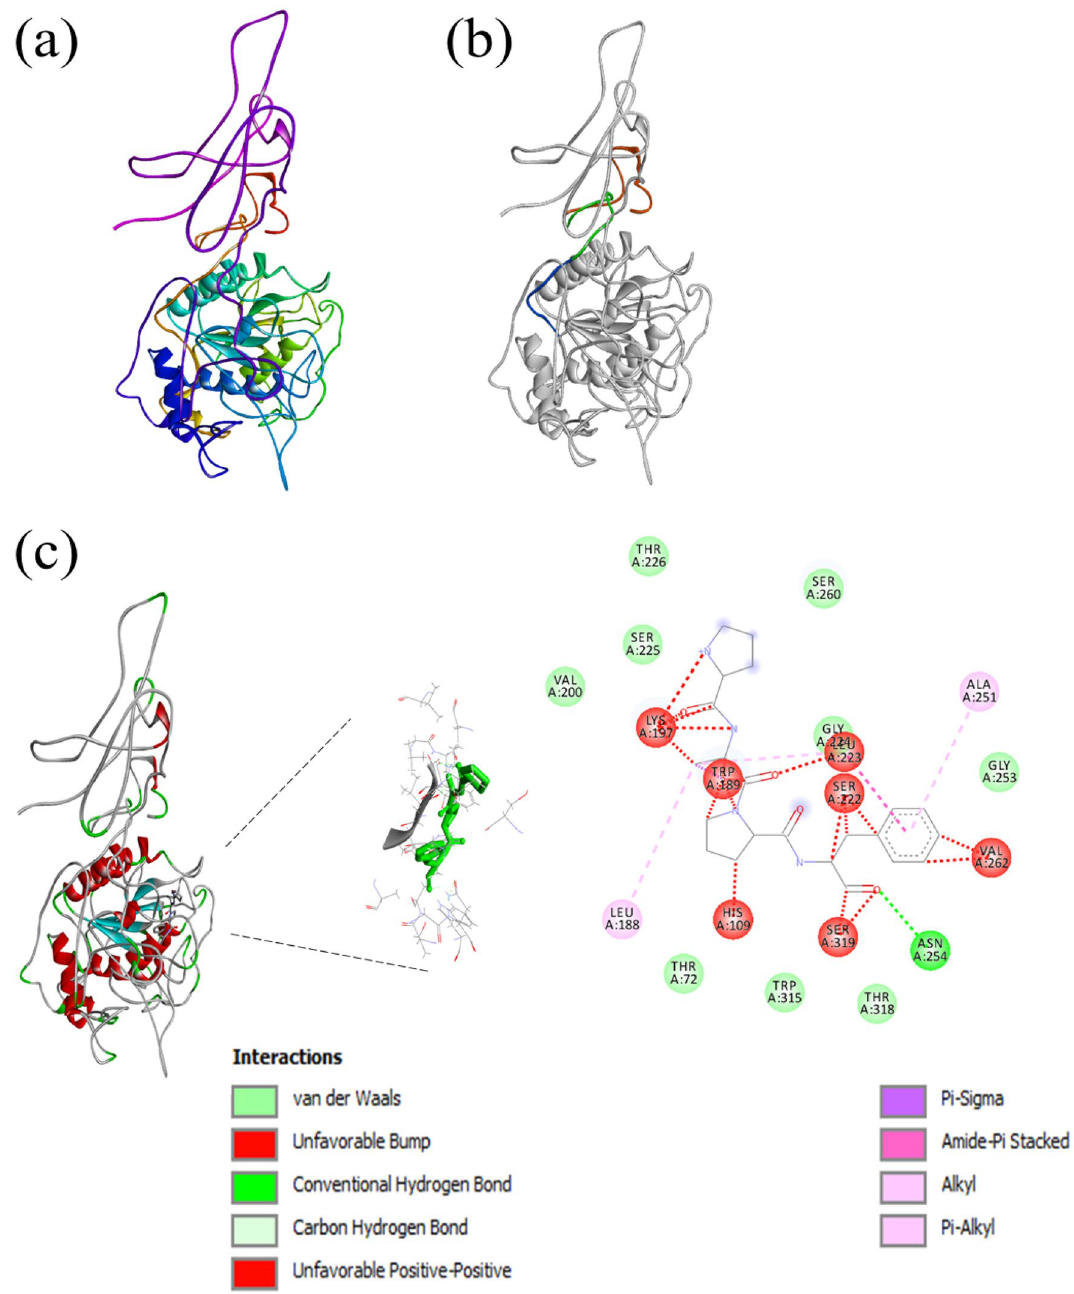
Figure 3. Structural predictions. ( a ) I-TASSER structure prediction (https:// zhang lab. ccmb. med. umich. edu/I- TASSER/) and image retrieved from Discovery studio software (Discovery Studio Visualizer, v.17.2, San Diego: Dassault Systèmes, 2016), ( b ) The signal peptide region is colored, Red for N-terminal, Green for H-terminal and Blue for C-terminal (http:// www. cbs. dtu. dk/ servi ces/ Signa lIP/), ( c ) The ligand binding site predicted by I-TASSER (109-HIS,189-TRP, 222-SER, 223-LEU, 224-GLY, 225-SER, 251-ALA, 253-GLY, 254-ASN, 318-THR, 319-SER) (https:// zhang lab. ccmb. med. umich. edu/I-